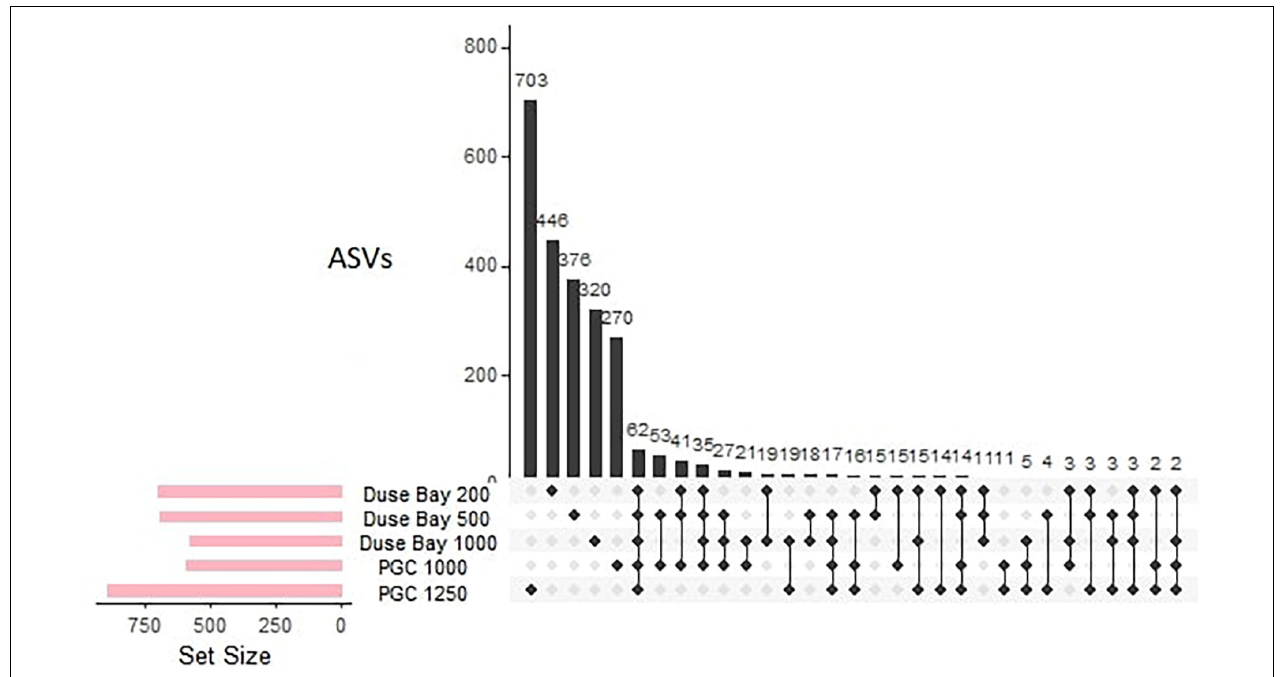
FIGURE 4 | UpSet plot of all ASVs assigned a “Nematoda” label (all layers considered, three to four replicates). The left barplot (Set Size) represents the total number of ASVs per station; the bottom plot shows every possible intersection between sets and the top barplot displays their occurrence.